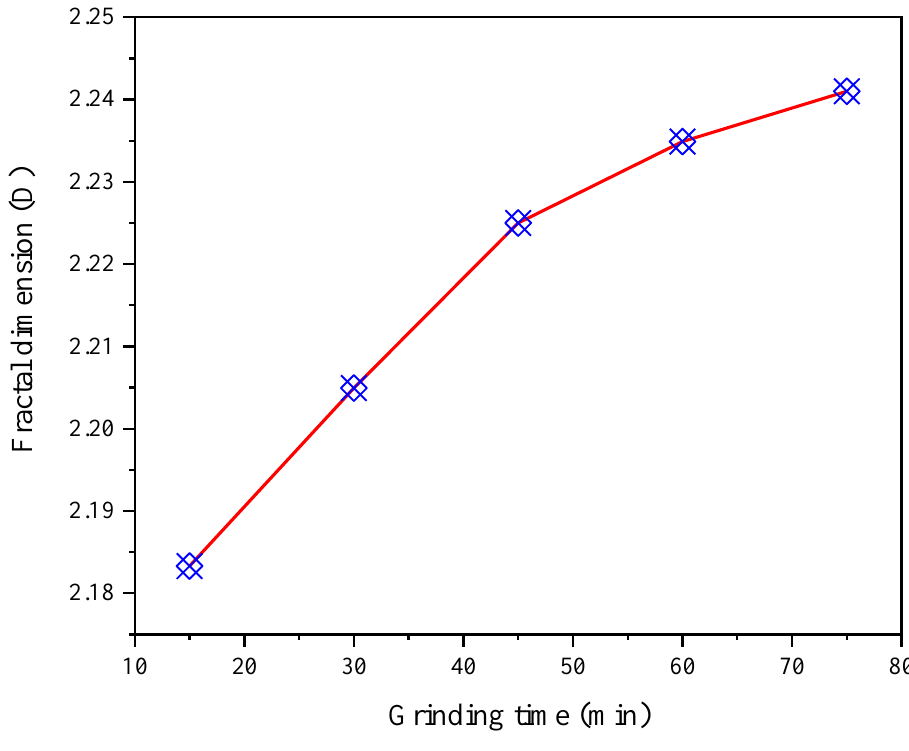
Figure 9. Relationship between grinding time and fractal dimension.